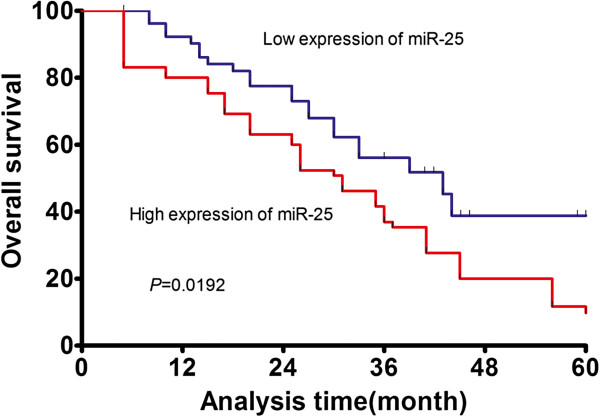
Survival analysis of 131 hepatocellular carcinoma patients by Kaplan-Meier method. Overall survival rate in patients with high miR-25 expression was significantly lower than that in patients with low miR-25 expression (p=0.0192).